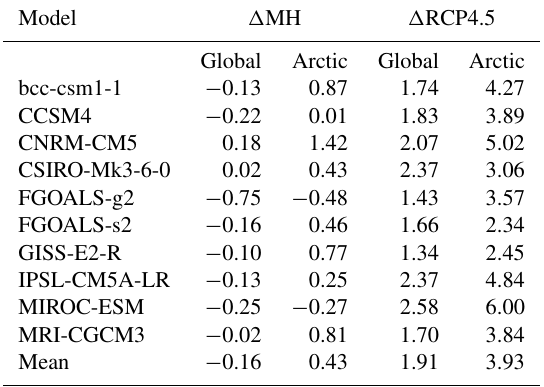
Table 2. Models used in the current study and the annual, global, and Arctic (north of 60 ◦ N) mean surface air temperature changes ( ◦ C).